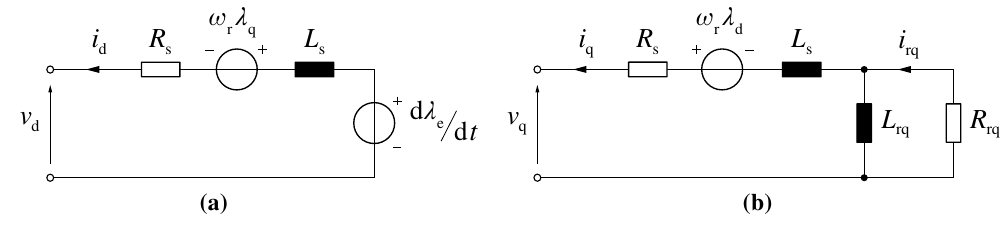
Figure 10. S-VSC d-axis ( a ) and q-axis ( b ) equivalent circuits.